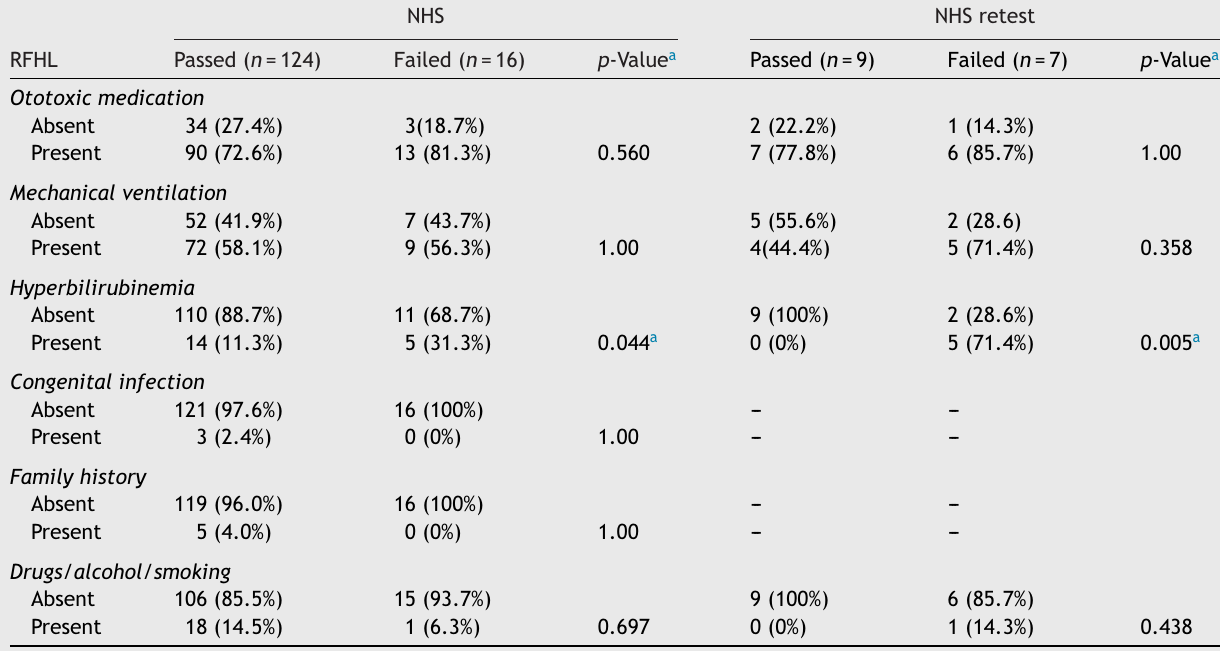
Table 2 Risk factors for hearing loss (RFHL) and audiological